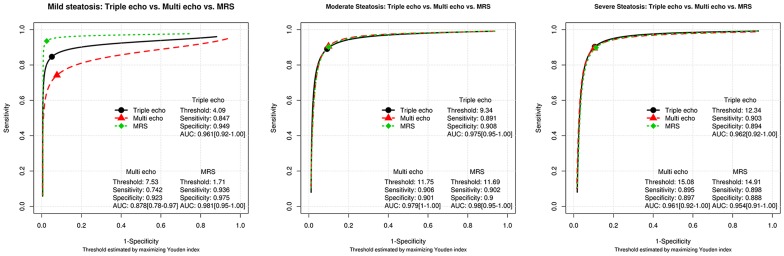
Diagnostic performance for triple- and multi-echo sequences, and MRS using histopathology as the gold standard.The best cut-off point was identified using the Youden index.